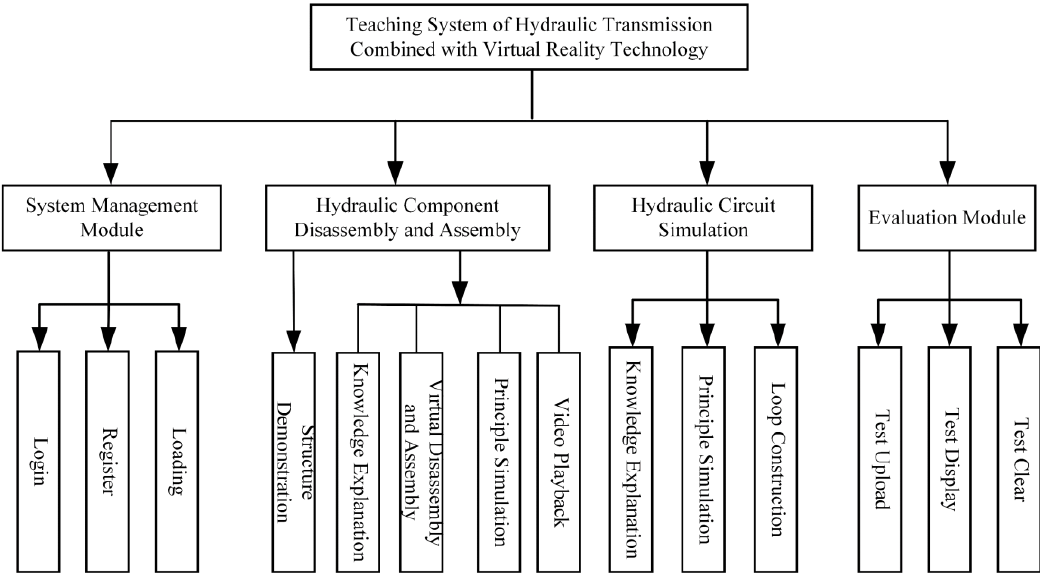
Figure 3. The functional structure of the hydraulic transmission teaching system.